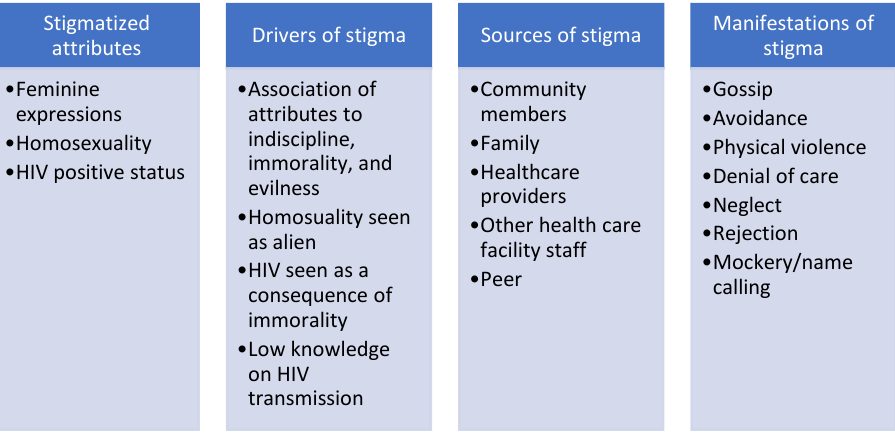
Figure 1. Snapshot of Rapid Analaysis Results.